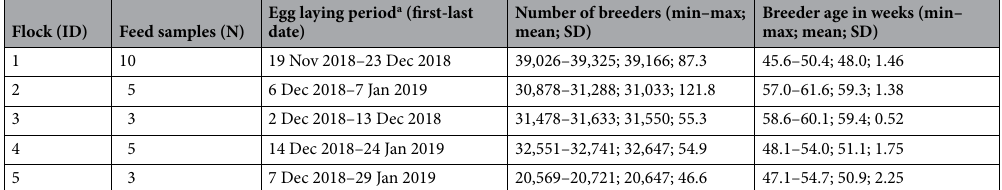
Table 1. Flocks and production periods. a First feed sample was obtained 10 days before the first day of the